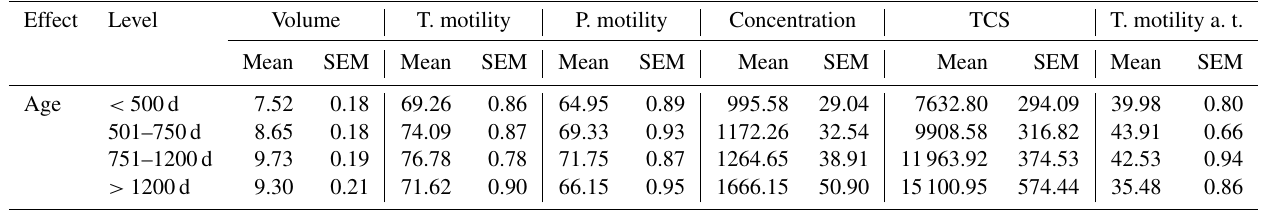
Table 3. Means and standard error of the means of dependent variables according to different age classes. Effect Level